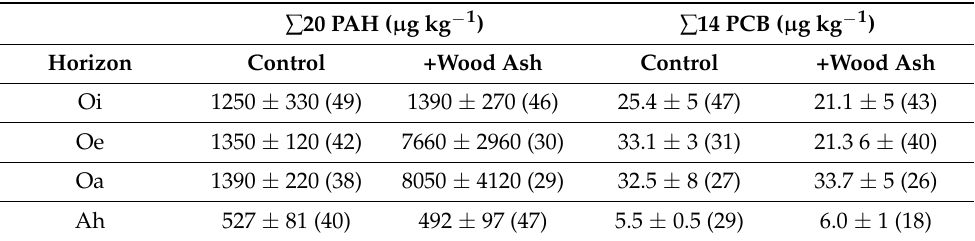
Table 12. Mean concentrations ± standard errors of ∑ 20 polycyclic aromatic hydrocarbons (PAH), and ∑ 14 polychlorinated biphenyls (PCBs) in the control plots ( n = 4) and in the soil surface horizons 1 y after application of 8 Mg ha − 1 wood ash. The percentage of low molecular weight PAH (LMPAH) and lower chlorinated PCB (LCPCB) is given in parentheses. Data from